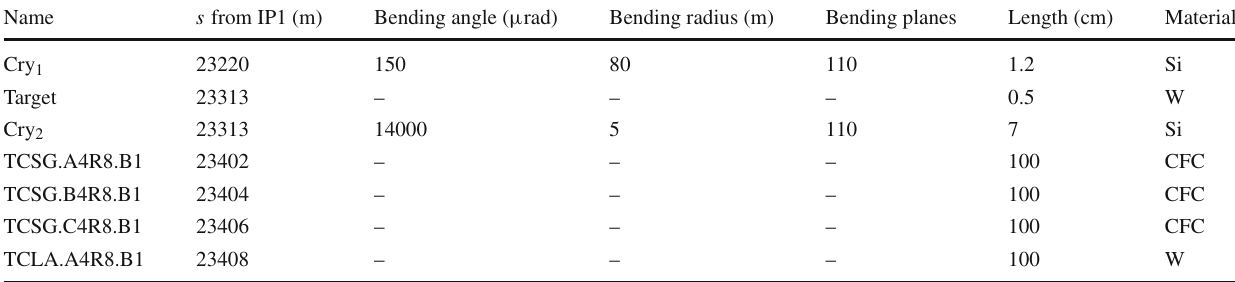
Table 1 Installation position and main features of the proposed experimental layout in IR8. All the components act on the vertical plane